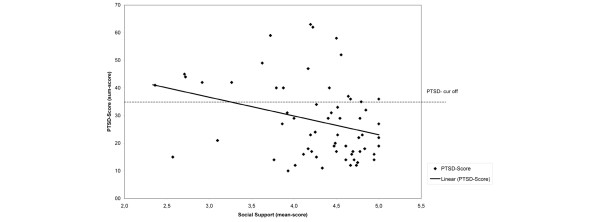
Correlation of perceived social support and posttraumatic stress. The total sum score of questionnaire F-Sozu and post-traumatic stress disorder (PTSD) score is shown. Severity of PTSD was verified with the Post-Traumatic Stress Syndrome 10-Questions Inventory (PTSS-10) score. Diagnosis of an increased risk for development of PTSD was related to a cutoff score of 35 or more in PTSS-10. The cutoff score is denoted by a broken horizontal line; social support was significantly correlated to severity of PTSD (Pearson correlation; p < 0.05).